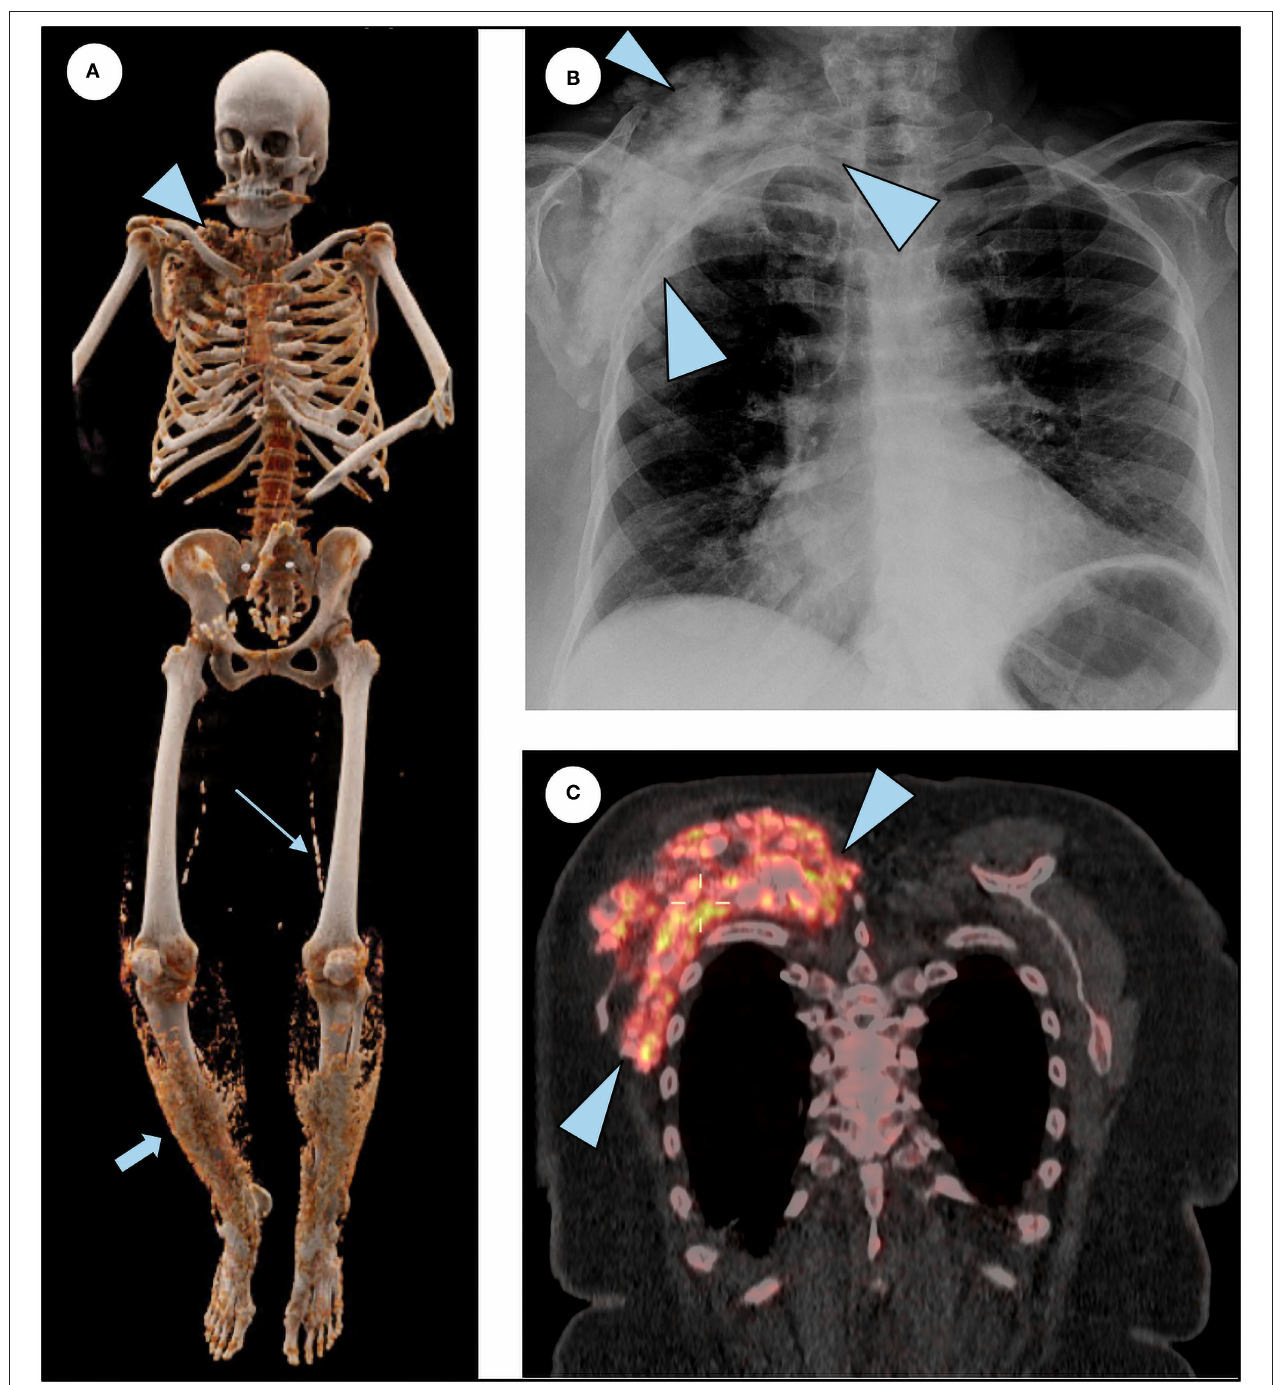
FIGURE 3 | Additional features of HFTC. (A) 3D reconstruction of a total body CT scan illustrates subcutaneous calcifications surrounding the right shoulder (arrowhead), superficial lacey calcification in the lower extremities bilaterally (short arrow), and calcifications of femoral arteries (long arrow). (B) Chest radiograph shows right shoulder calcification (arrowheads). (C) Coronal slice of the merged 18 F NaF PET/CT scan demonstrating intense tracer uptake in the actively forming calcific lesion seen in the chest radiograph